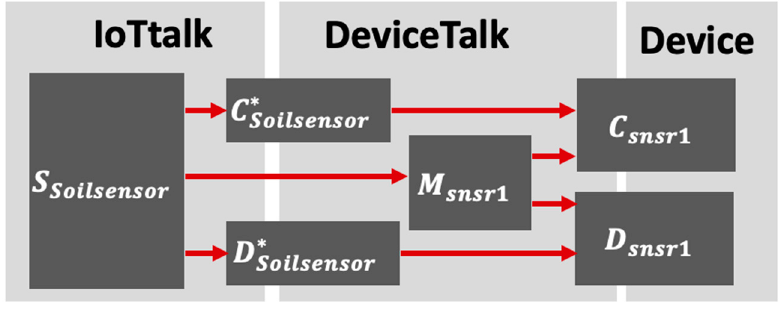
Figure 10. The SA/DA code generation for the snsr1 device from the SoilSensor device model.